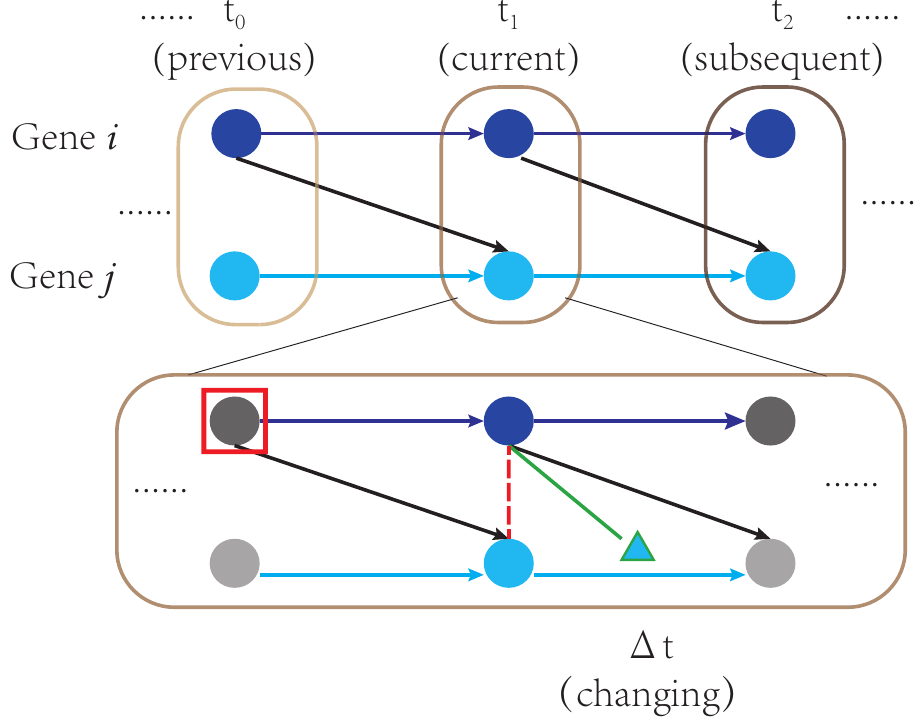
Figure 1. Illustration of a time-lagged relationship across three time points. The gray rectangles represent different individual cells. Multi-trace measurements of three cells ( top ) and one cell’s continuous measurements ( bottom ) are shown. The colored circles represent measurable gene expression levels, while the grey circles represent unmeasurable gene expression levels. The triangle represents the changing expression level of gene j in ∆ t . The blue and black arrows represent true causal relationships between genes across time. The green bar represents the causality between the current and changing expression levels. The red dotted line represents the relationship between the current expression levels of genes, confounded by the previous expression level of gene i framed by the red